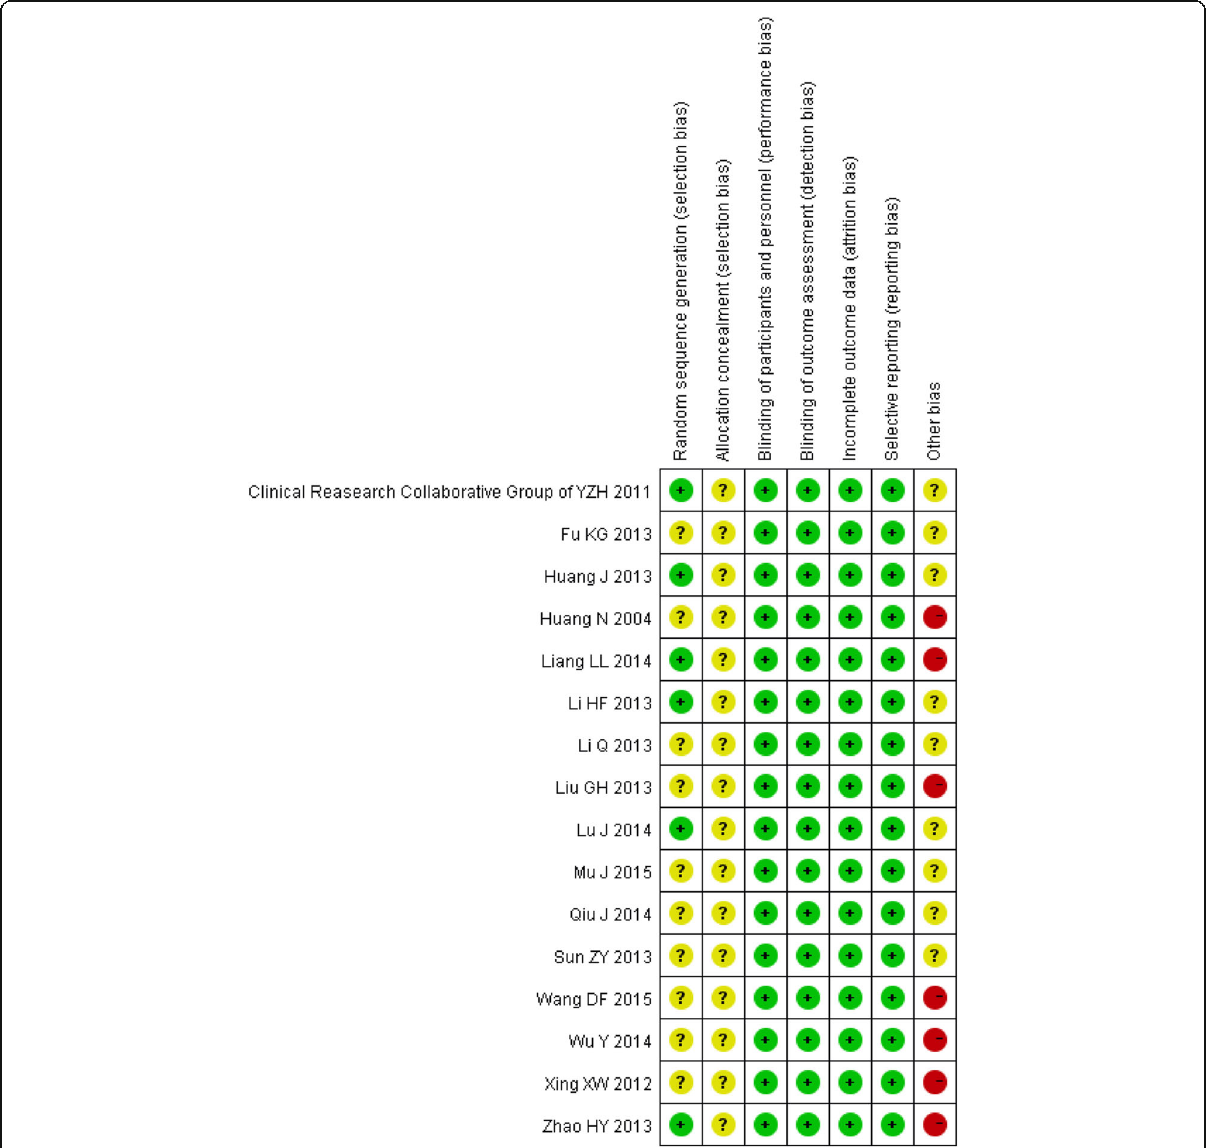
Fig. 2 Risk of bias summary. Note: In each item, the color of green represents low risk of bias, the yellow represents unclear risk of bias, while the red represents high risk of